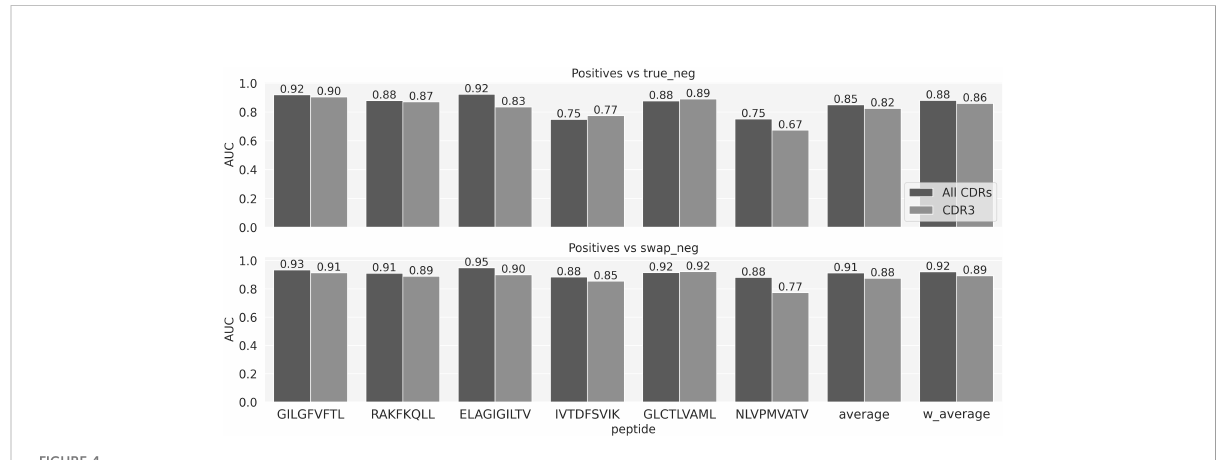
FIGURE 4 Performance comparison in terms of AUC for the NetTCR model using all CDR loops versus using only CDR3 loops from both a - and b